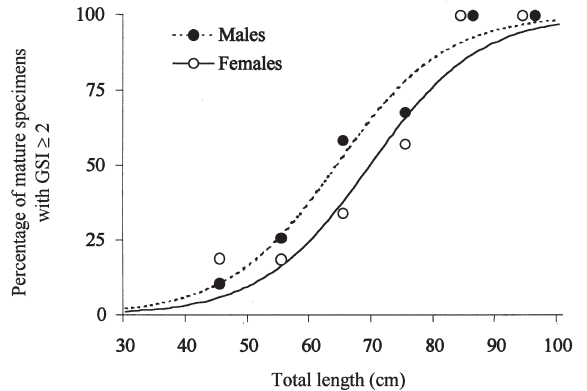
) in shelf samples and G